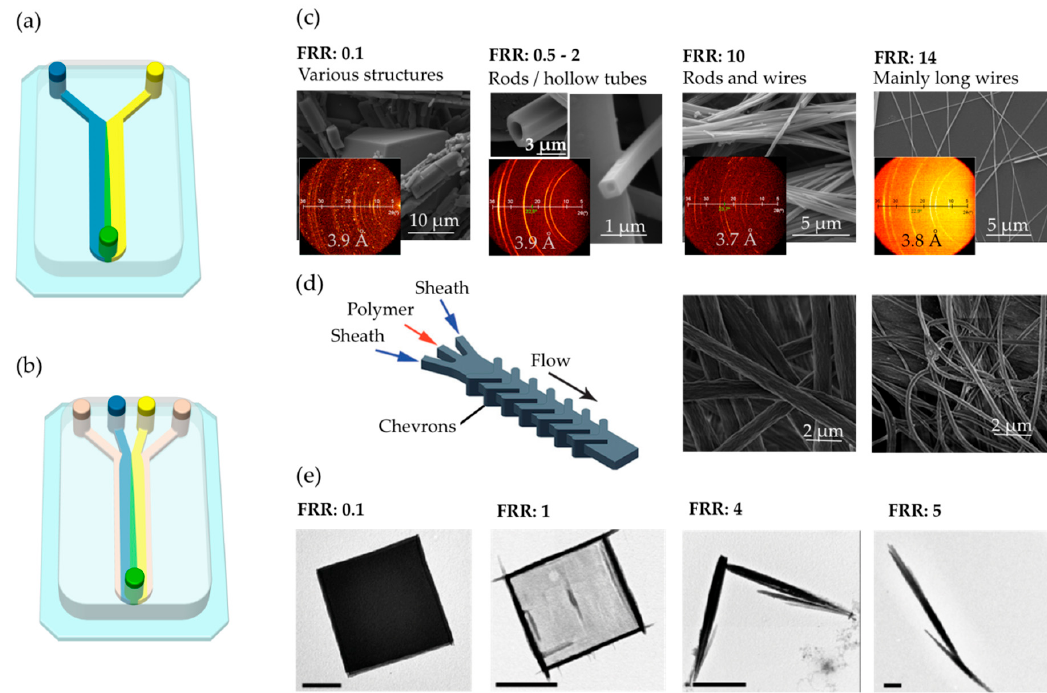
Figure 2. Schematic illustrations of ( a ) two laminar co ‐ flowing streams and ( b ) a flow ‐ focusing microfluidic set ‐ up (or hydrodynamic focusing). As in Figure 1, the yellow and blue colors indicate reactants, white is the pure solvent, and green the reaction area where RD conditions are settled. In ( c ) are scanning electron microscopy (SEM) images of TTF–Au composites generated at flow rate ratios (FRRs) of 0.1, 0.5–2, 10 and 14, with their respective two ‐ dimensional (2D) X ‐ ray diffraction (XRD) spectra. Each 2D XRD spectra indicates the pi ‐ stacking distance between TTF molecules in the composite (reproduced with permission from Wiley ‐ VCH [23]). ( d ) Drawing of a flow ‐ focusing device incorporating chevrons and SEM images of the poly(methylmethacrylate) PMMA fibers synthetized (Reproduced with permission from RSC [10]). ( e ) Transmission electron microscopy (TEM) images of the coordination polymers (CP) synthetized at different FRRs. Here, the scale bars are 1 μ m. (Reproduced with permission from Wiley ‐ VCH [24]).